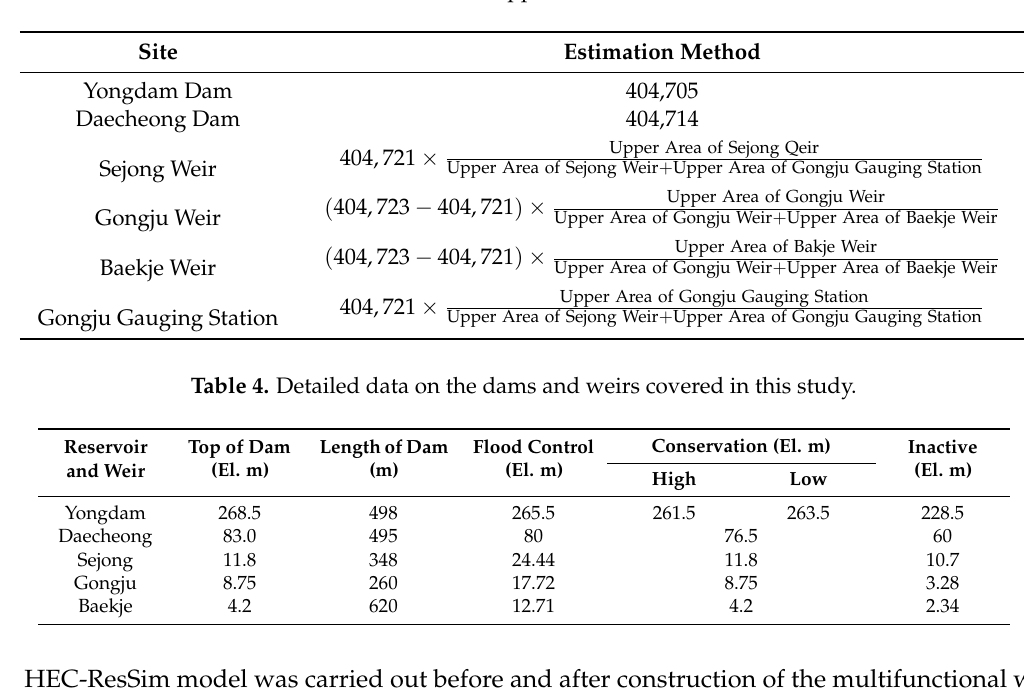
Figure 5. Plot of water level versus storage capacity of dams and weirs: ( a ) dams; and ( b ) weirs. Table 3. Estimation of inflow for application to the HEC-ResSim model.